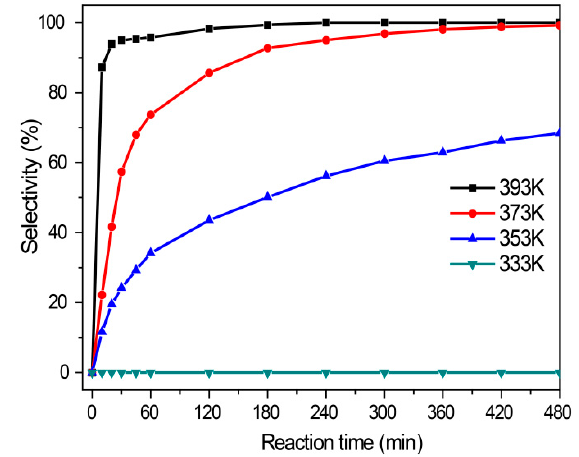
Figure 10. Selectivity of target product in benzlyation of mesitylene.